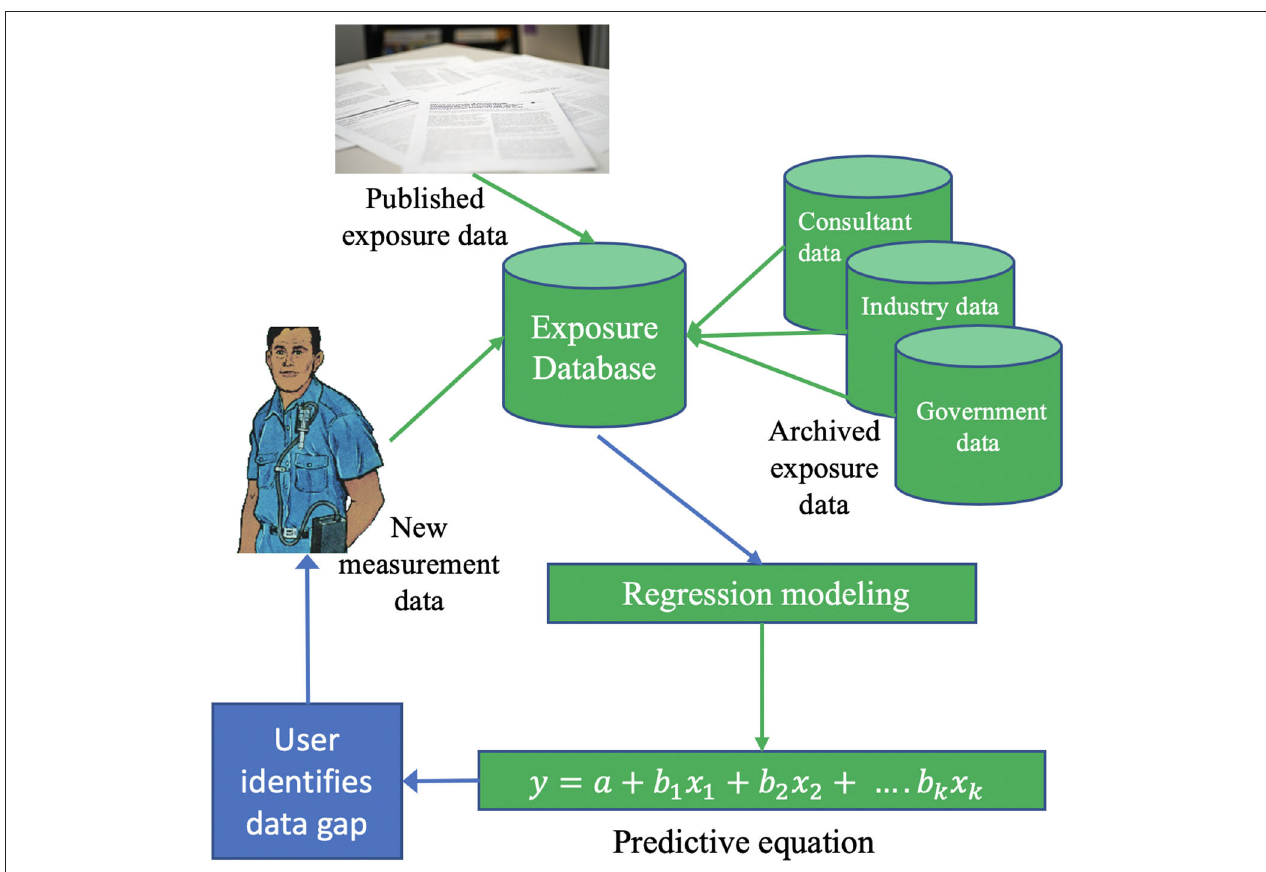
FIGURE 1 | Exposure data capture and flow in final design. After the initial population of the exposure data base from archived data, it can be easily and routinely updated with newly acquired exposure data. The need for exposure monitoring is indicated where work is being done and no data exists in the database to permit modeling and exposure estimation. Initially, new exposure data collection was subsidized to encourage timely